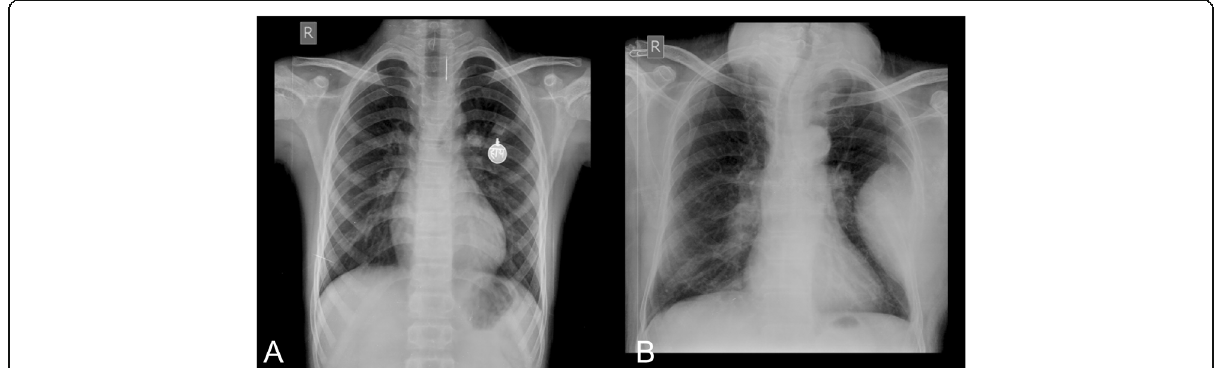
Fig. 5 a False positive — the algorithm misinterpreted the artifact as nodular opacity. b False negative — the algorithm failed to identify the pleural based mass as “ Pathology